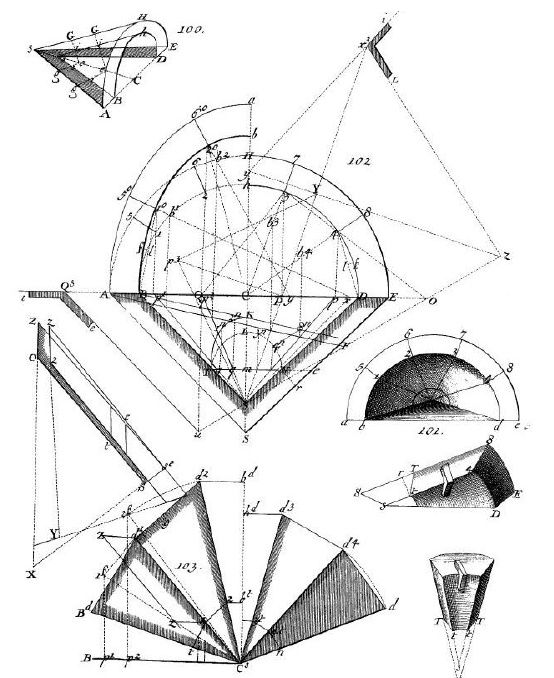
Figure 4. M. Frezier, Conical trompe, tav. 62, Volume